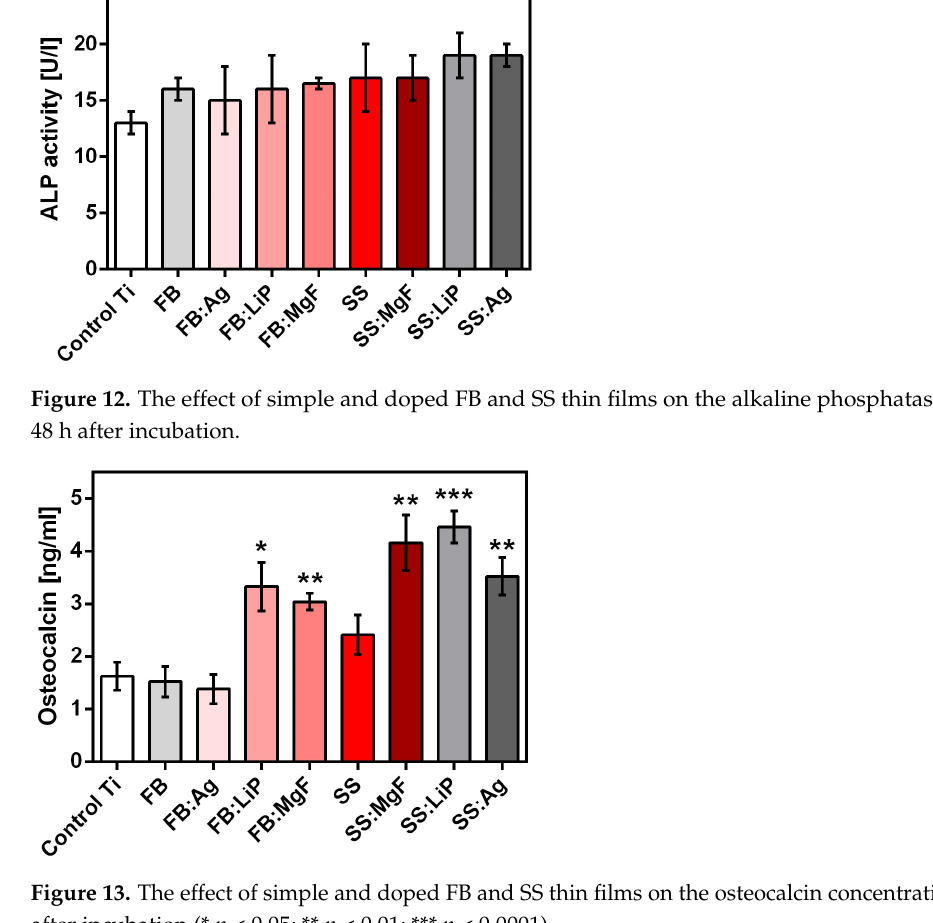
Figure 13. The e ff ect of simple and doped FB and SS thin fi lms on the osteocalcin concentration, 48 h after incubation (* p < 0.05; ** p < 0.01; *** p < 0.0001).